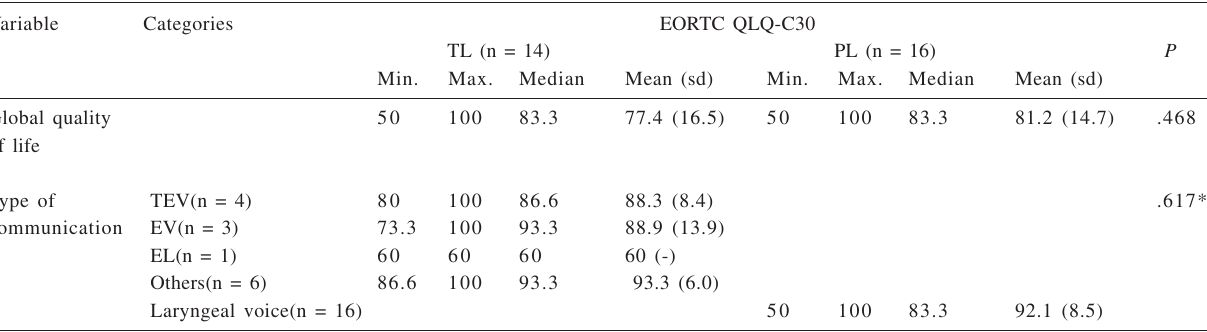
Table 1 - Result of the global quality of life and type communication in the groups of the total and partial laryngectomy